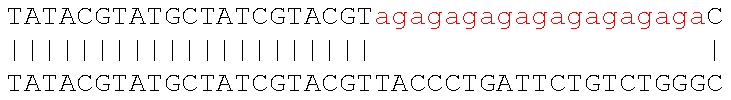
Alignment problem using a mask score of 0.This kind of nonsensical alignment may occur if masked letters (lowercase red) always receive a score of 0.